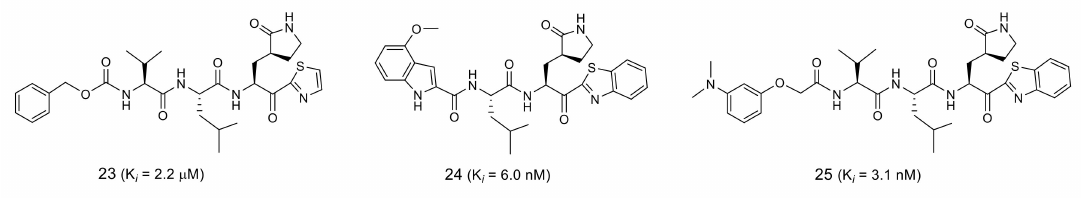
Figure 6. Inhibition with peptides having thiazolyl ketone warhead.